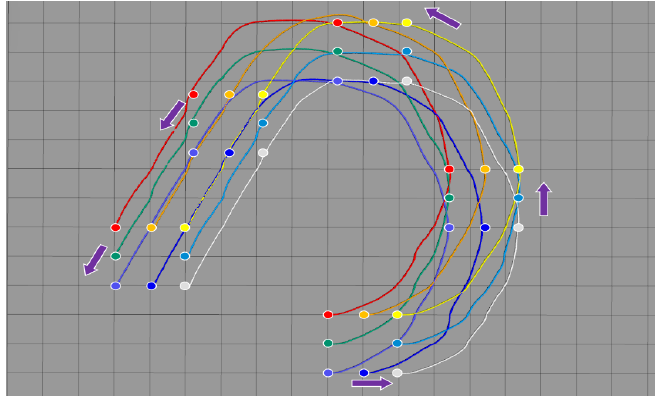
Figure 6. The trajectory of the multi-robot collaborative